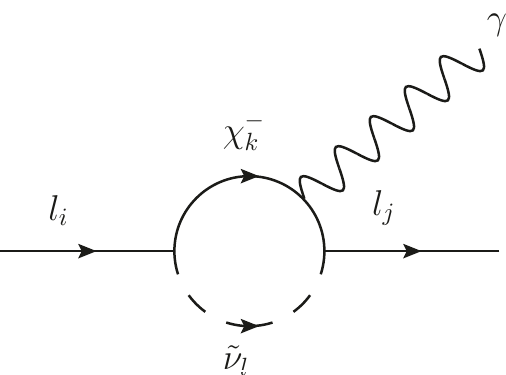
Figure 1 . Feynman diagram for charged lepton (cid:13)avor violation which changes compared to the case of the MSSM extended by right-handed